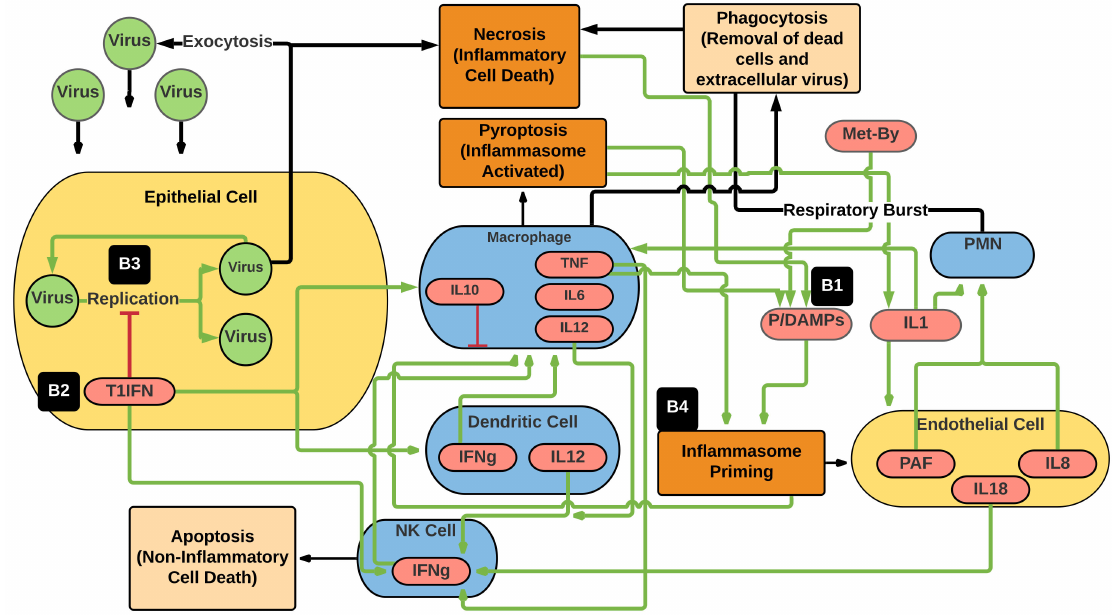
Figure 1. Schematic of the main cell types, mediators, interactions, and functions represented in the CBIABM. Blue ovals represent immune cell types; yellow ovals represent non-mobile cells; green circles represent virus; red ovals are molecular species; beige rectangles represent non/anti-inflammatory processes; orange rectangles represent proinflammatory processes. Green arrows represent positive or stimulatory interactions; red connectors represent negative or inhibitory interactions; black arrows represent cellular functions facilitated by the connected cell types. Note that the primary means of suppressing viral infection is through the death of infected epithelial cells, either by apoptosis or necrosis; both pathways lead to decreased numbers of healthy epithelial cells (%System-Health). In addition, note that the differences in bat and human parameterization are seen at: B1 = increased P/DAMPS by the addition of higher metabolic byproduct (Met-By) reflecting increased metabolism in bats, B2 = baseline production of type 1 interferons (T1IFN), B3 = enhanced antiviral effect of T1IFNs and B4 = decreased inflammasome activity. T1IFN = type 1 interferons, P/DAMPS = pathogen/damage-associated molecular patterns, Met-By = metabolic byproduct, PAF = platelet-activating factor, IL1 = interleukin 1, IL2 = interleukin 2, IL6 = interleukin 6, IL10 = interleukin 10, IL12 = interleukin 12, TNF = tumor necrosis factor, IFNg = interferon-gamma, PMN = polymorphonuclear neutrophil, NK cell = natural killer